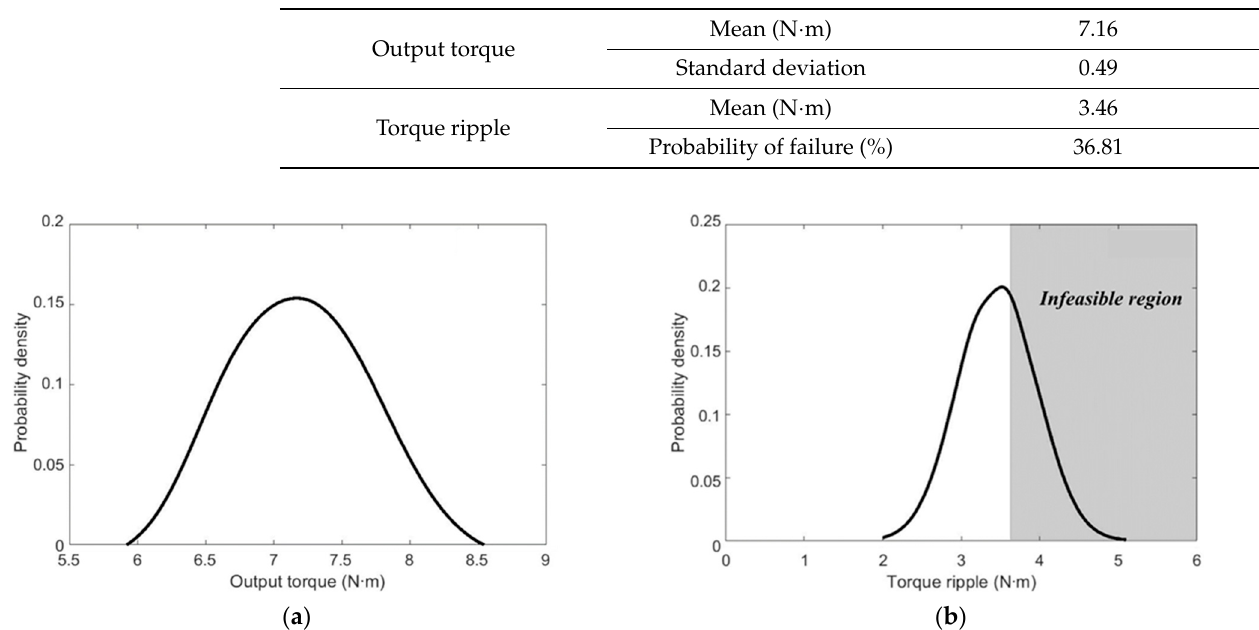
Figure 10. Probability distributions of ( a ) output torque and ( b ) torque ripple of the BLDC motor.